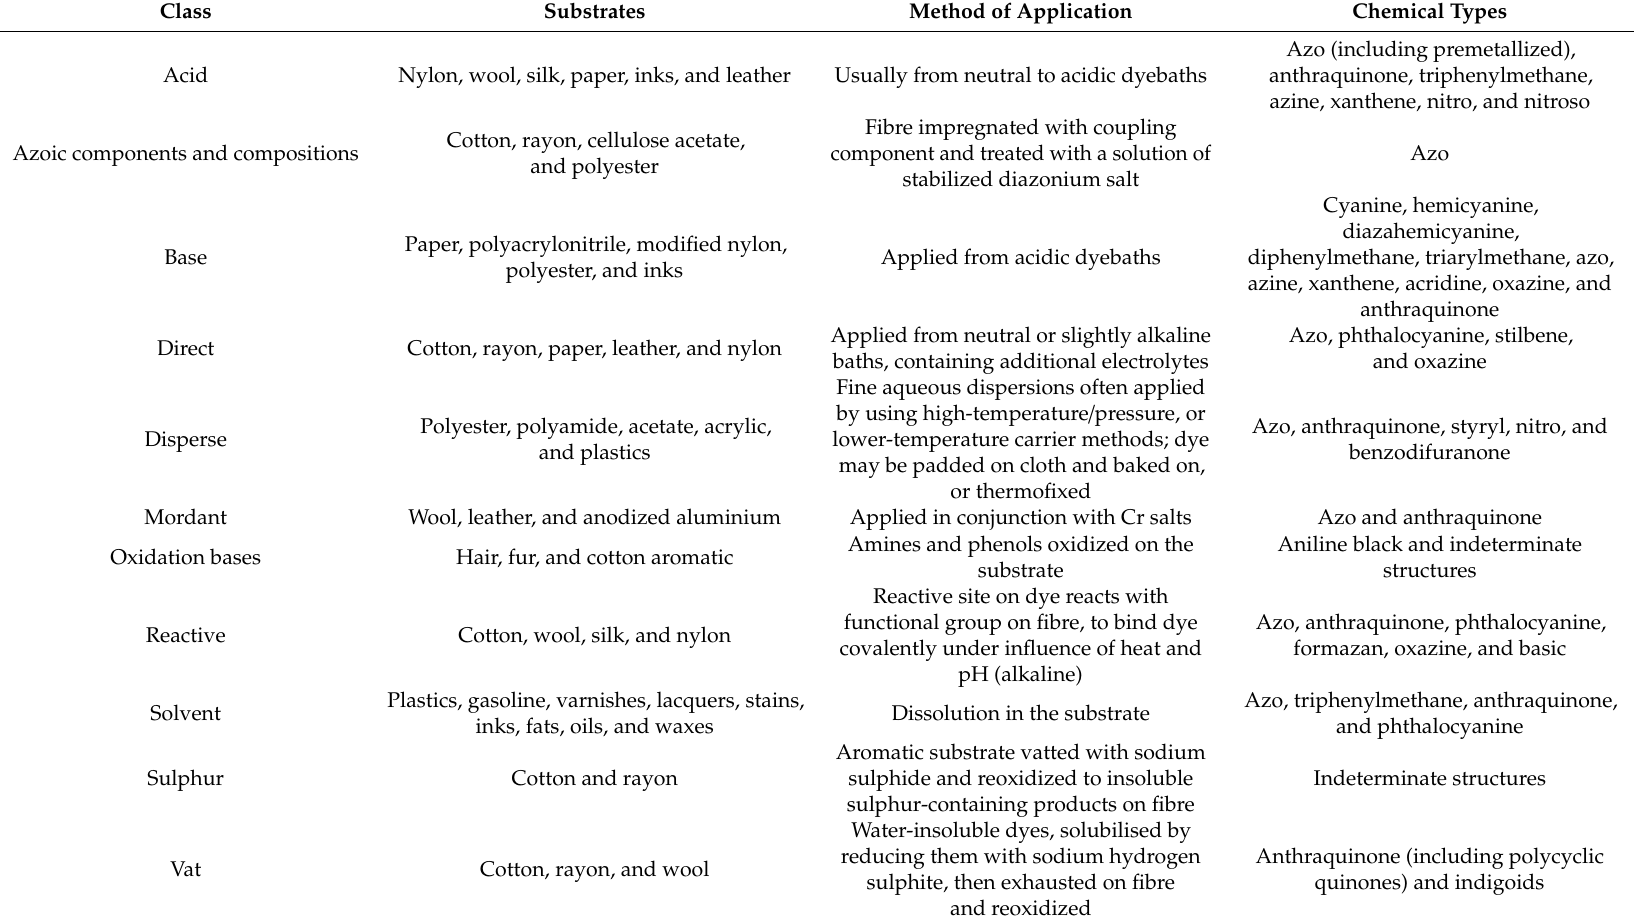
Table 2. Classes of di ff erent dyes